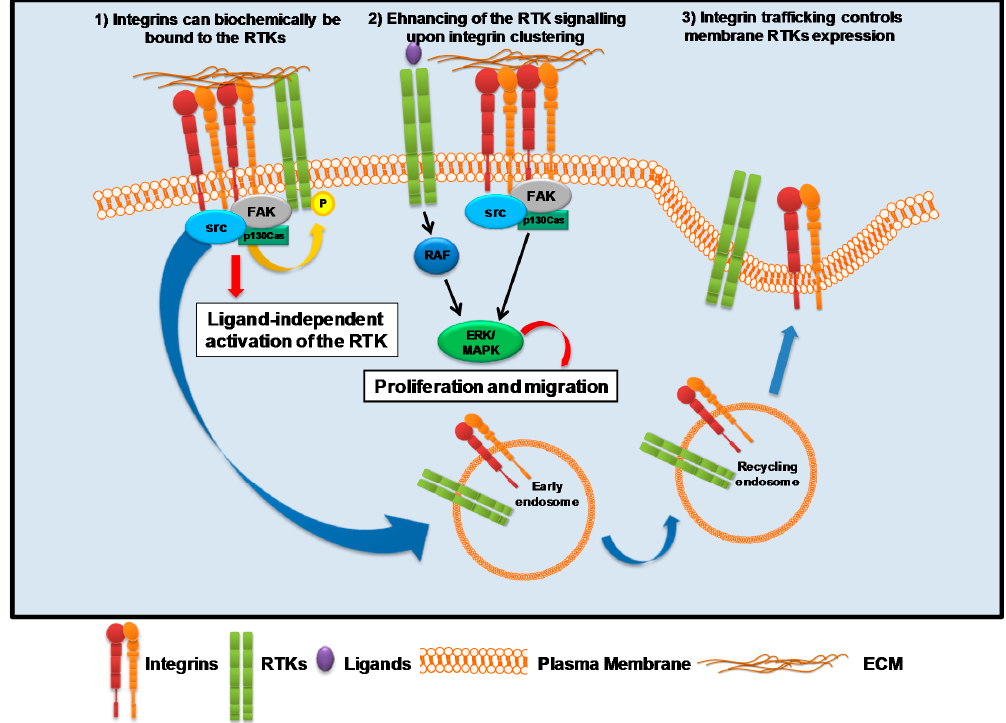
Figure 2. Schematic representation of the the signaling cascades activated in cancer cells by the cross-talk between integrins and RTKs. The arrays indicate: black, signaling cascades; yellow, phosphorylation; discontinuous, possible signaling cascades; blue, trafficking; red, effect. The abbreviations are: RTK, Receptor Tyrosine Kinase; ECM, Extra Cellular Matrix, MAPK, Mitogen Activated Protein Kinase, FAK, Focal Adhesion Kinase; src, Sarcoma viral oncogene; ERK, Extracellular signal-Regulated Kinase.